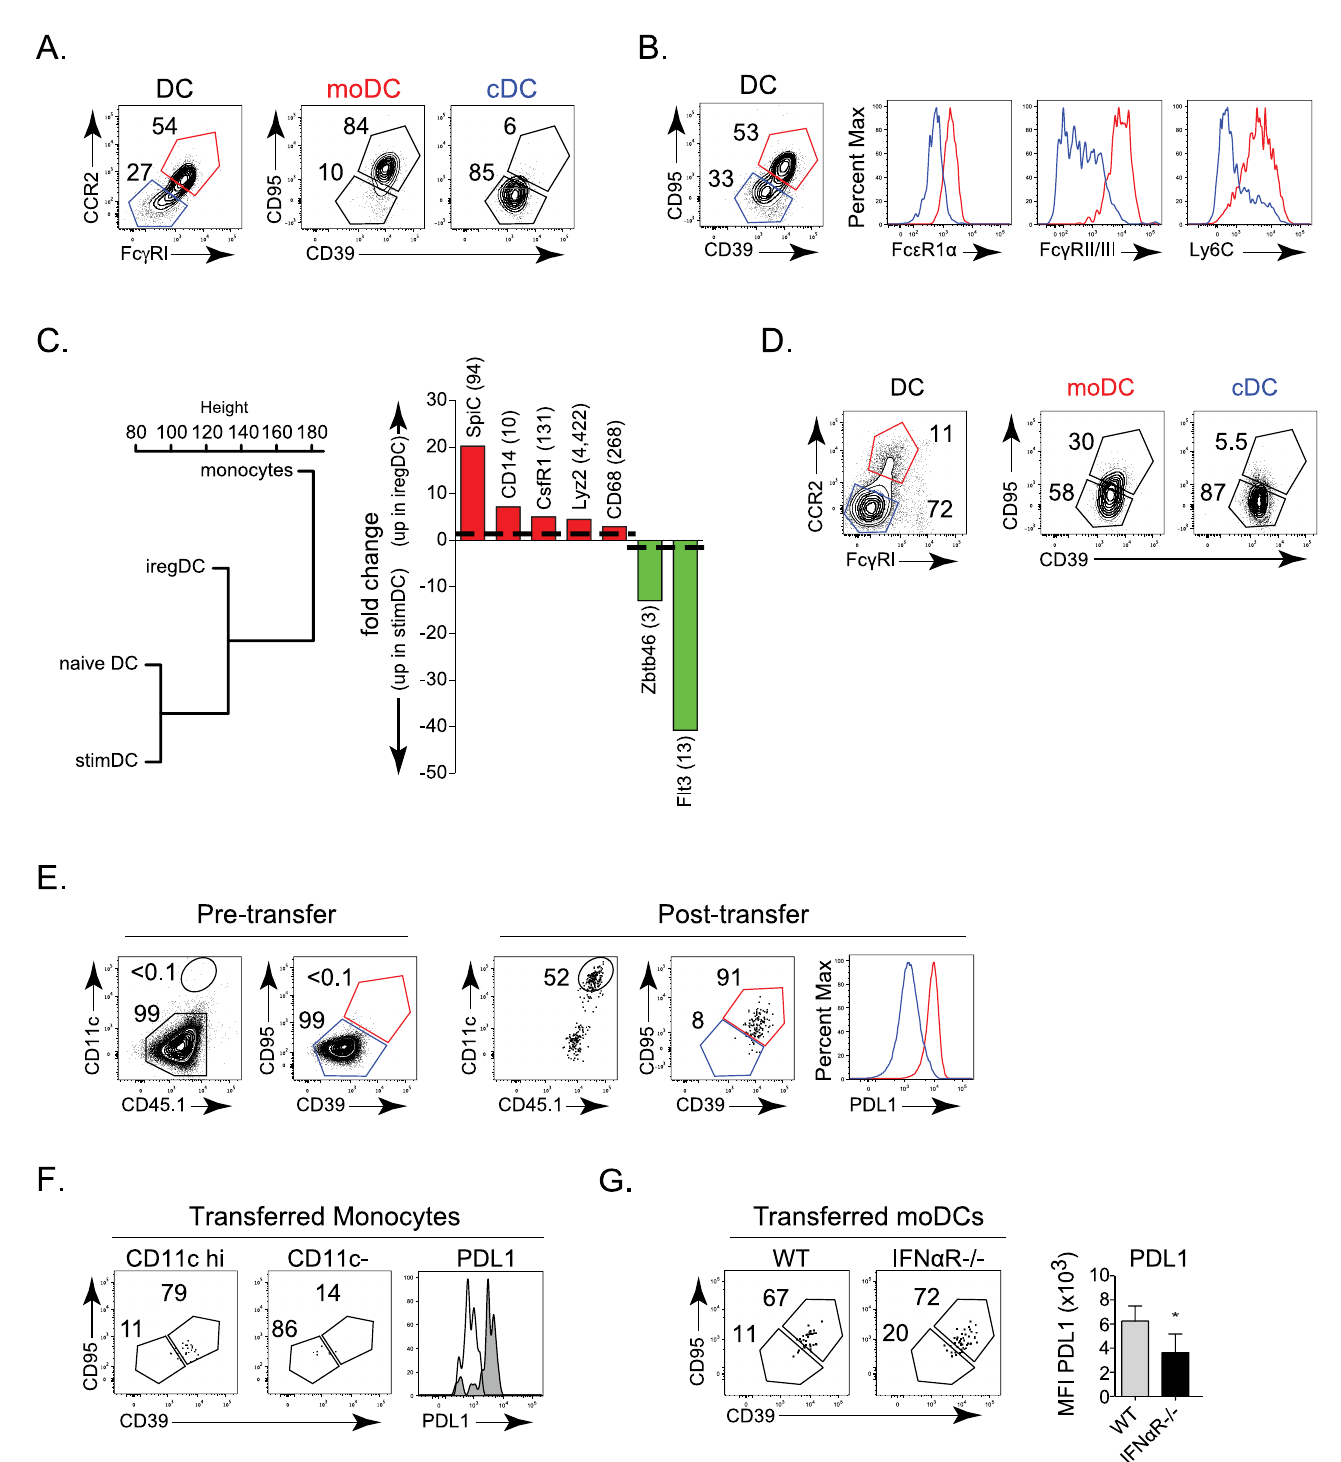
Fig 4. Suppressive iregDC are of monocyte origin. A. Flow plots show CCR2 and Fc γ RI expression on splenic CD11b+ DCs on day 9 after LCMV-Cl13 infection. CCR2+, Fc γ RI+ (red) and CCR2-, Fc γ RI- (blue) populations are subsequently plotted on iregDC markers CD95 and CD39. B. Expression of Fc ε R1 α , Fc γ RII/III, and Ly6C on iregDCs (red) and stimDCs (blue) gated on CD95 and CD39 from CD11b+ DCs on day 9 after LCMV-Cl13 infection. C. Dendogram representing the gene expression profile relation between na ï ve monocytes, na ï ve DCs, iregDCs and stimDCs at day 9 of LCMV-Cl13 infection. Bar graph of the expression of key monocyte-associated (red) and conventional DC-associated (green) genes. Numbers in parenthesis indicate the RPKM